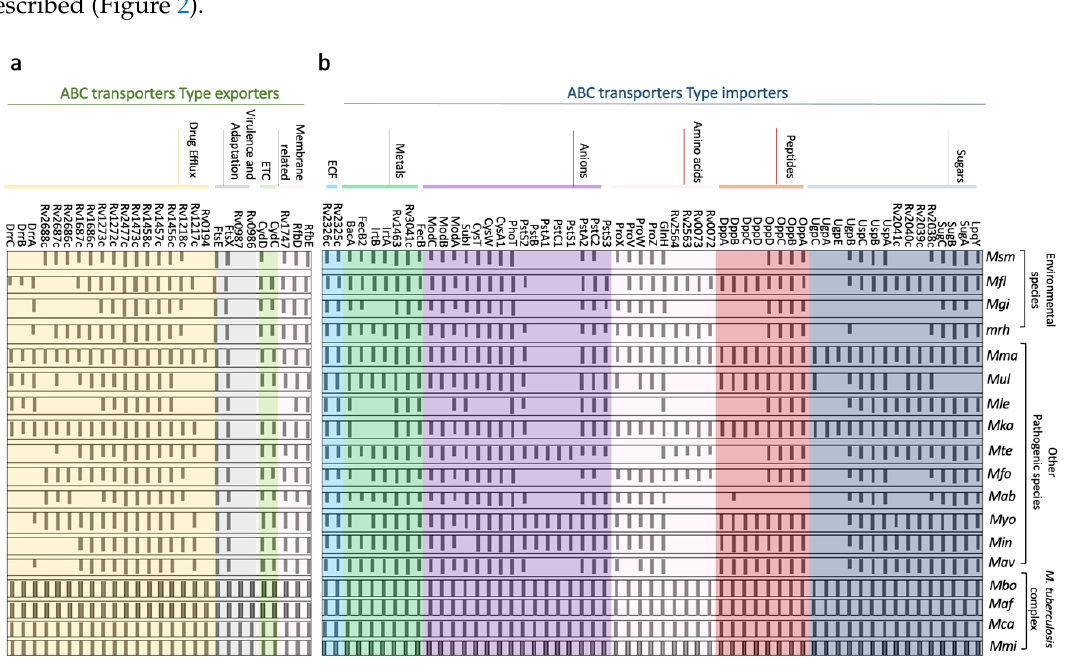
Figure 2. Distribution of the identified M. tuberculosis ABC transporters across species of Mycobacterium genus. ( a ) ABC export systems, ( b ) ABC (ABC) import systems. The amino acid sequences of M. tuberculosis components were used as a query for ortholog searching in the KEGG (Kyoto Encyclopedia of Genes and Genomes) orthologist tool [129]. The species are classified into three groups: M. tuberculosis complex, other pathogenic species, and environmental species. Each bar corresponds to the amino acid sequence identity (100% to 0%) of that specific protein related to the M. tuberculosis putative